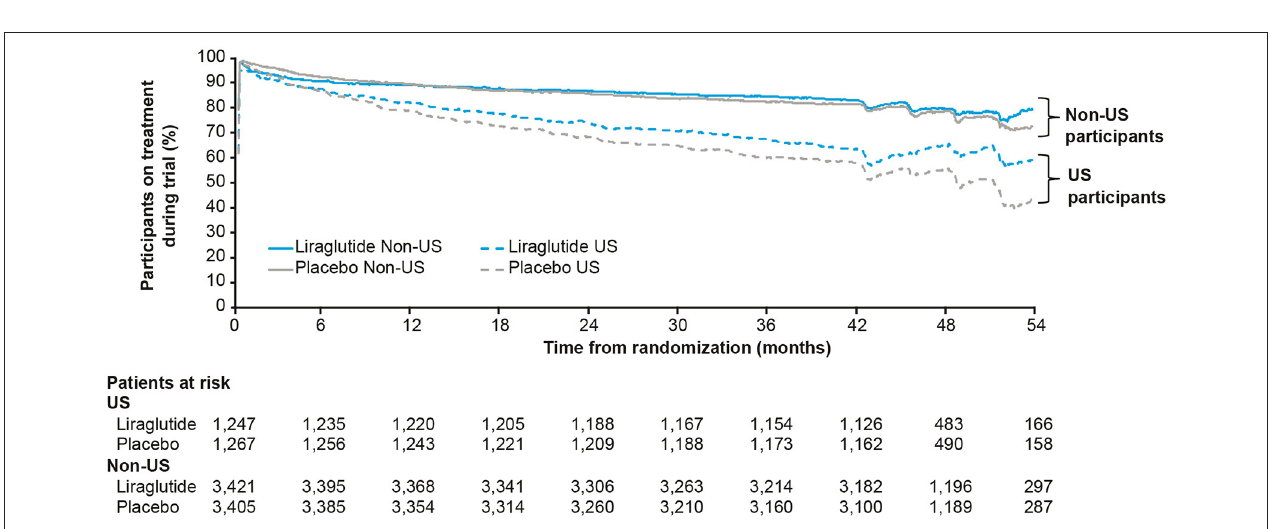
FIGURE 3 | Percentage of US and non-US participants on treatment with liraglutide or placebo during the LEADER trial (30). Full analysis set. US, United States.